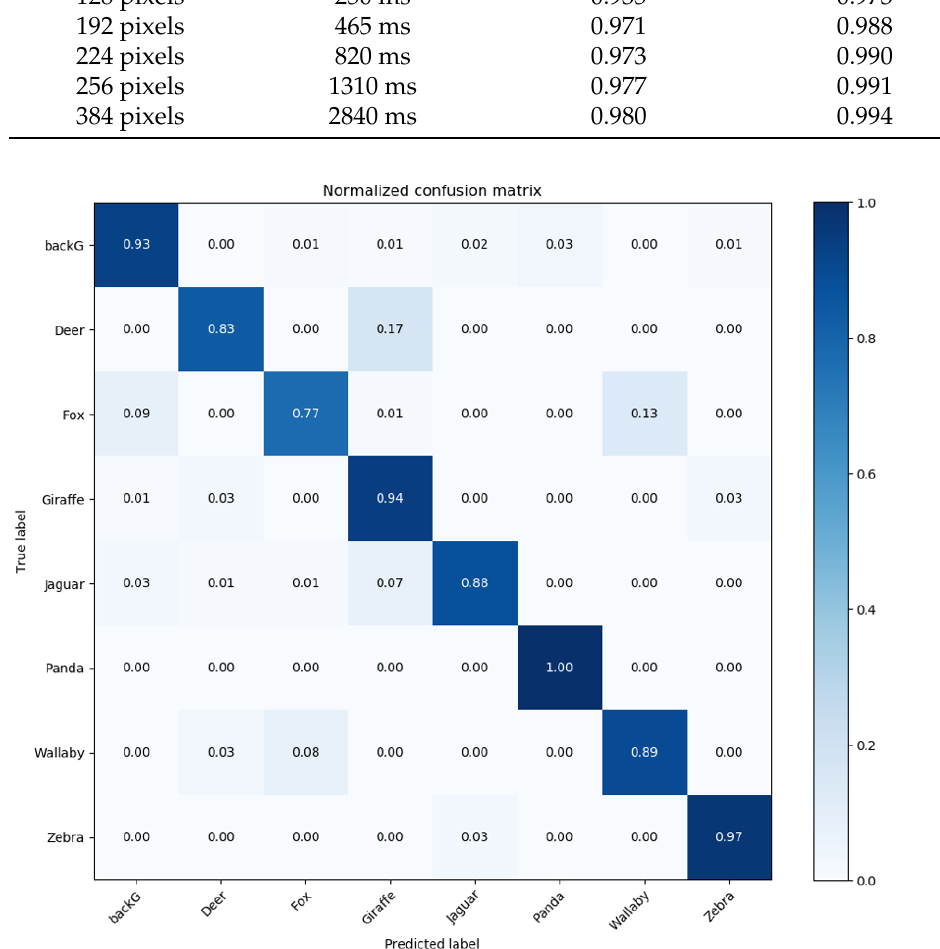
Figure 3. Recognition accuracy with seven animal